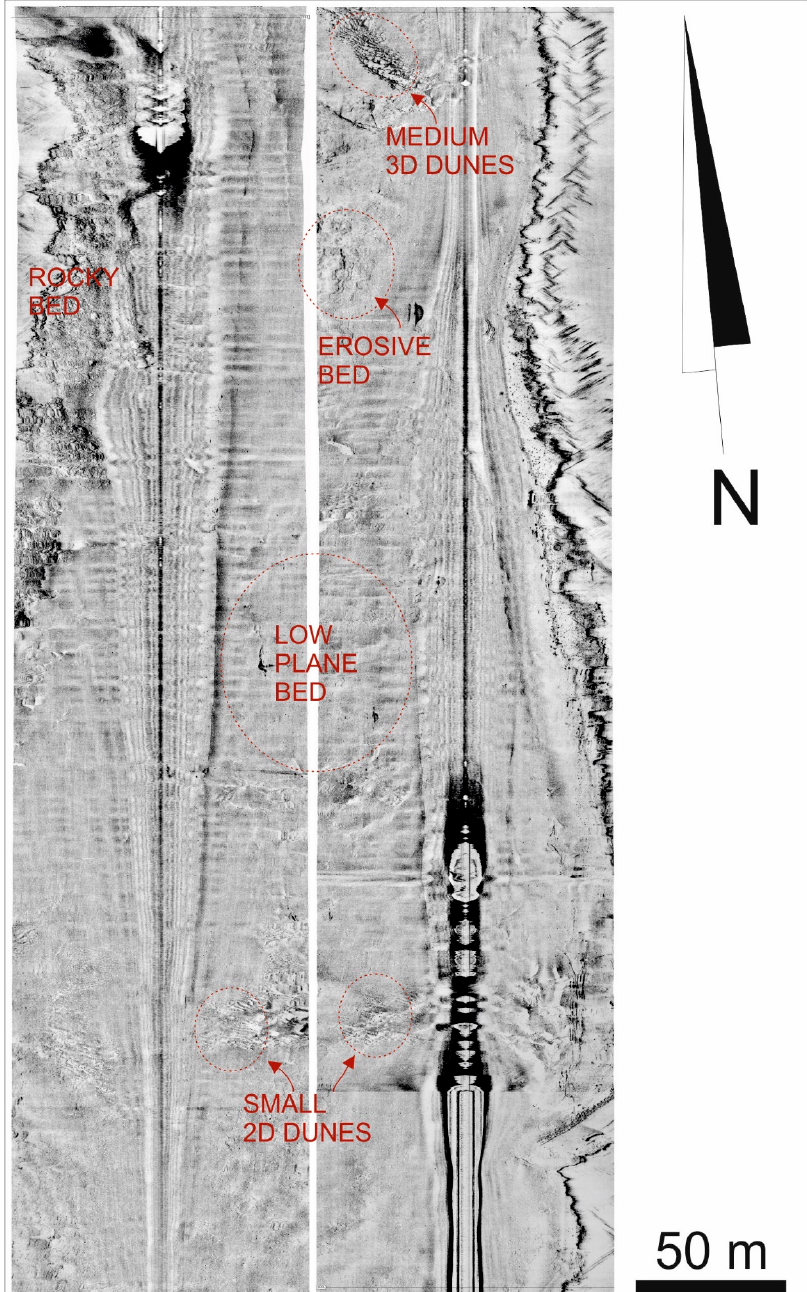
Figure 6. Side-Scan Sonar records covering the inner area. The main distinguished bed features are indicated.